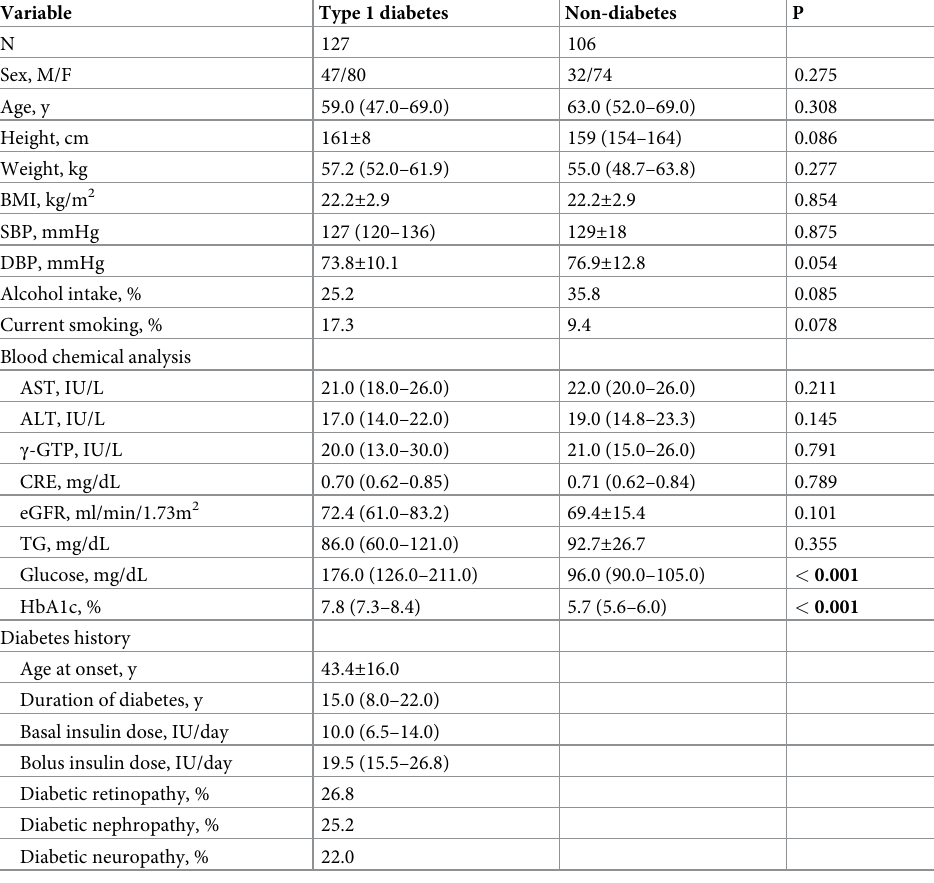
Table 1. Characteristics of the type 1 diabetic and non-diabetic patients.